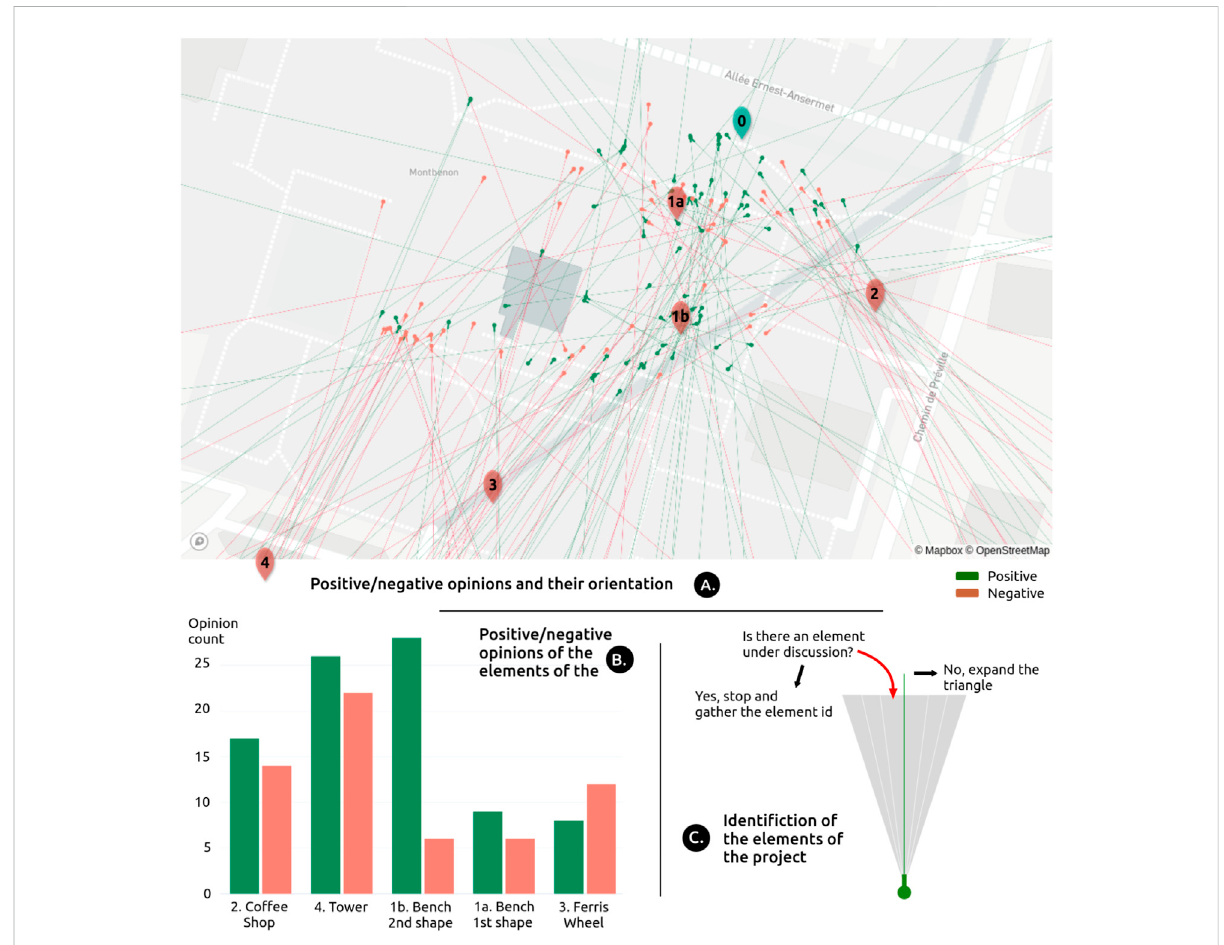
FIGURE 6 Analysis of the project ’ s elements targeted by the participant contributions. (A) Raw orientations of the contributions are classi fi ed as positive/ negative. (B) Positive/negative distribution of the objects of the project. (C) Adopted method to recover the targeted objects from a position and an